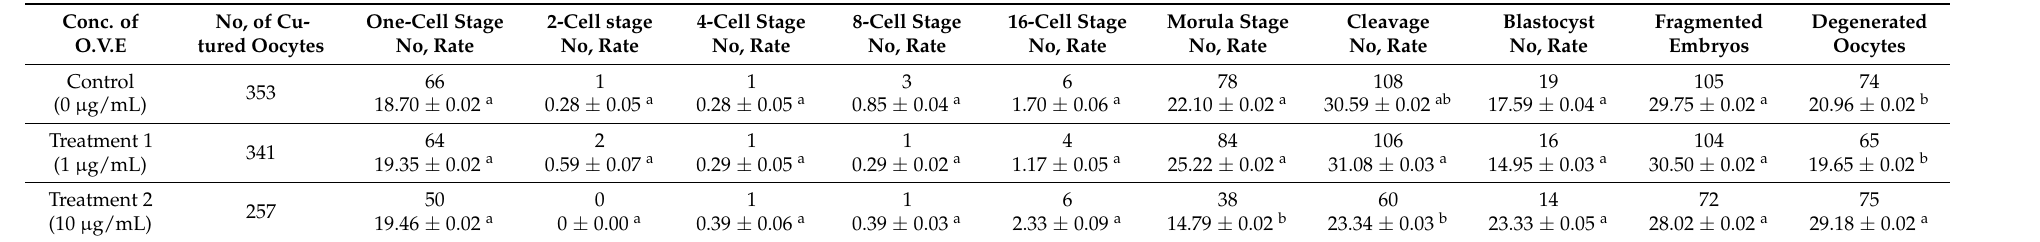
Table 4. The effect of the O. vulgare extract on the numbers and proportions of sheep embryos developed in vitro. Conc. of